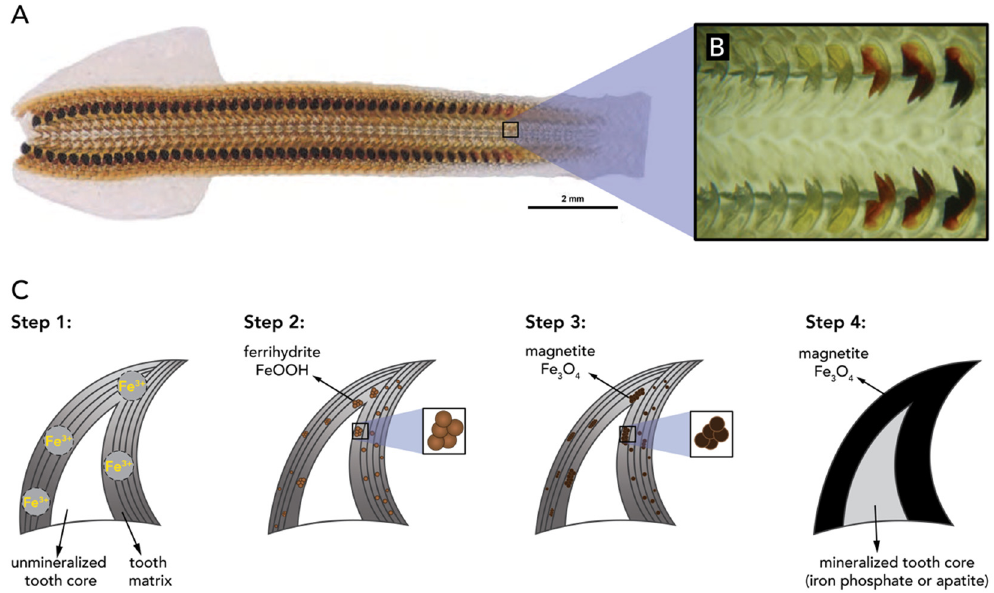
Figure 21. Chiton teeth and their formation. ( A ) Light micrograph of the radula of the chiton Acanthopleura gaimardi . ( B ) Detail of progressive stages of radular tooth development. ( C ) Scheme of the hypothesized mechanism of iron mineral formation (ferrihydrite and magnetite) in chiton teeth. Step 1: Organic tooth matrix around the unmineralized tooth core, which adsorbed Fe 3 + ; Step 2: Fe 3 + is first transformed into ferrihydrite; Step 3: conversion of ferrihydrite into magnetite; Step 4: mineralization of magnetite shell proceeds and the tooth core is also mineralized to phosphates. Image A reproduced from [142] by Brooker and Shaw, 2012, reproduced under the terms of the Creative Commons Attribution 3.0 License. Image B is reproduced from [141] with permission from Springer Nature.